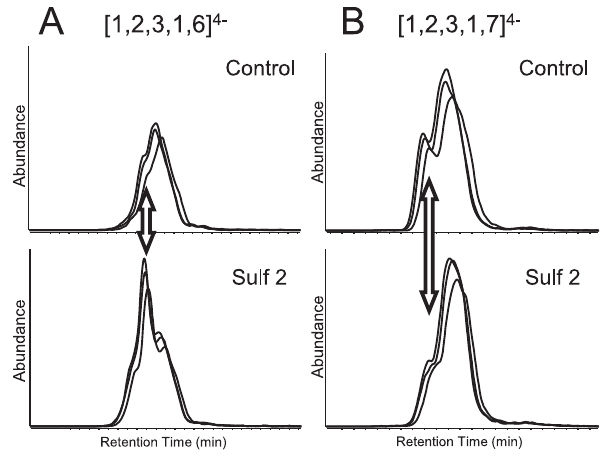
Figure 4. Extracted ion chromatograms (EICs) of -4 charged [1,2,3,1,6] and [1,2,3,1,7] before and after HSulf2 digestion from SEC-MS. EICs from three LC-MS runs were overlaid to the same scale and the double arrow shows the peak area that changed most upon HSulf2 digestion.